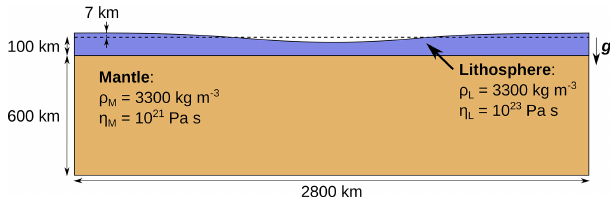
Figure C1. Setup for the rotation benchmark, assessing errors on the advection of particles.